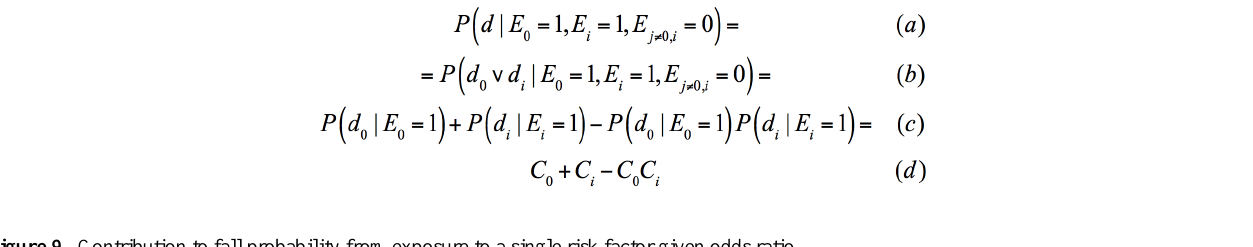
Figure 9. Contribution to fall probability from exposure to a single risk factor given odds ratio.